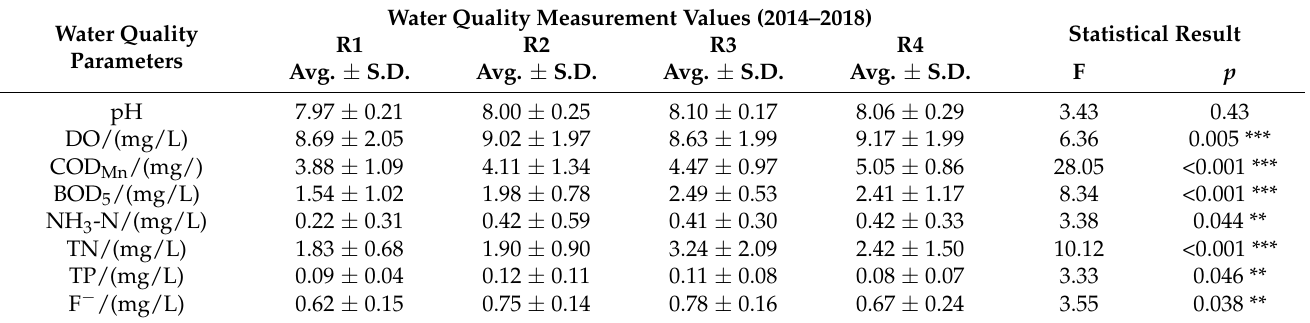
Table 3. The values of the eight water quality parameters in R1, R2, R3, and R4 of the SNWDPC- delivery ER’s